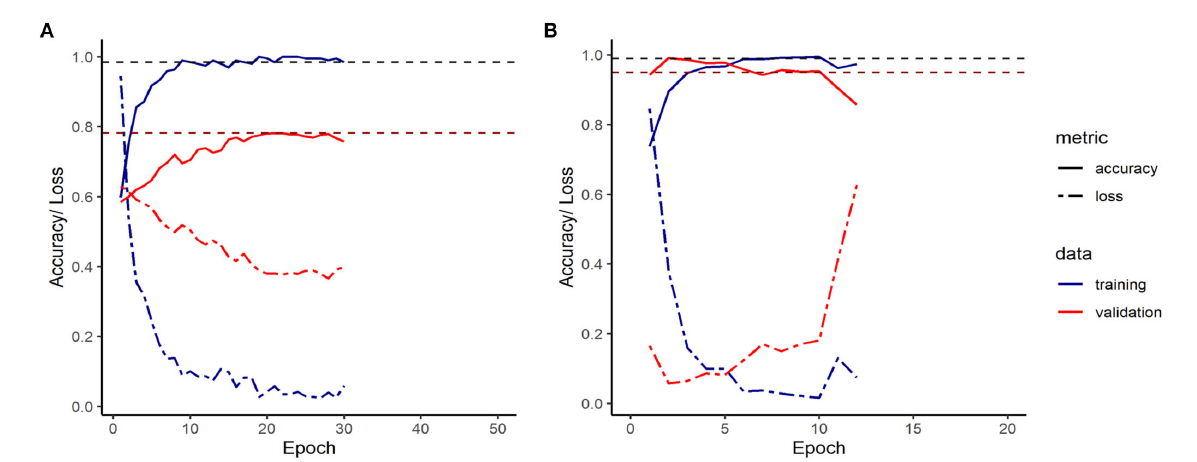
FIGURE5 Accuracy/ Loss plot for the final LSTM (A) and CNN (B) model. (The loss function utilized was the categorical cross